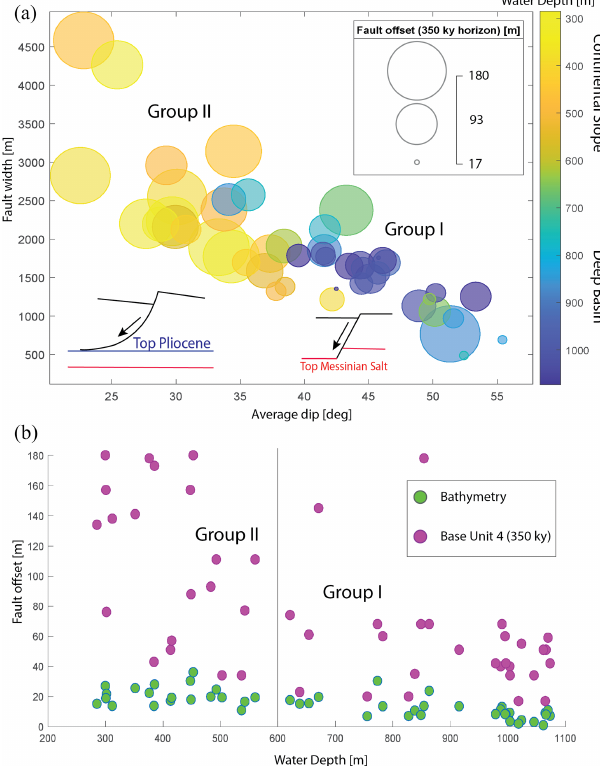
Figure 11. Panel (a) shows the relationship between the average faults dip angle, the fault width, the location of the fault along the slope (water depth), and the offset of base unit 4 horizon. Group II, located on the upper slope, is characterized by larger fault width (1.5–4.5km), gently dipping ( ∼ 30 ◦ ) fault planes and larger fault offsets. Panel (b) shows the difference between the offsets as they were measured on the seabed and base unit 4 (cumulative offset). The differences in faults offsets are much larger in Group